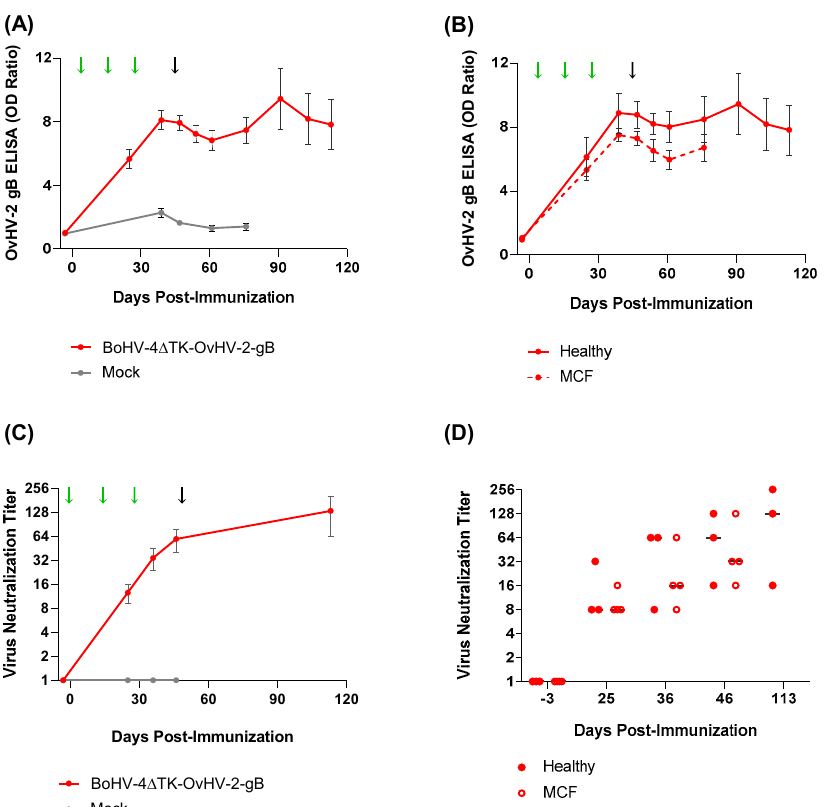
Figure 5. Antibody response induced by immunization with BoHV-4-A ∆ TK-OvHV-2-gB. Anti- OvHV-2 gB IgG (H+L) detected by ELISA in plasma samples from OvHV-2 gB vaccinated and control groups ( A ) and in OvHV-2-gB vaccinated animals that were protected (healthy) or unprotected (MCF) following OvHV-2 challenge ( B ). OvHV-2 gB neutralizing antibody activity in OvHV-2-gB- and mock-immunized animals ( C ) and individual neutralization titer (median) of vaccinated animals that were protected (healthy) following OvHV-2 challenge or unprotected and developed MCF ( D ). Error bars are SEM and arrows indicate days when animals were immunized (green) and challenged (black).